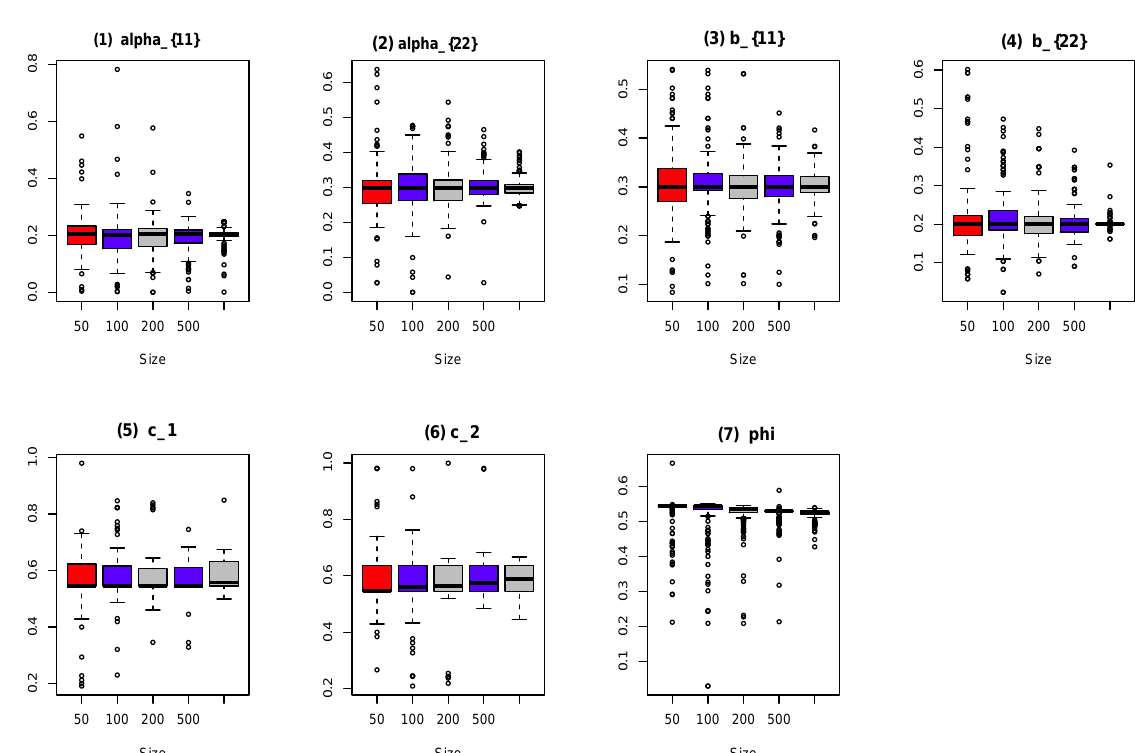
Figure 2. Boxplots of the CML estimates for diagonal EBINAR(1) model with parameter